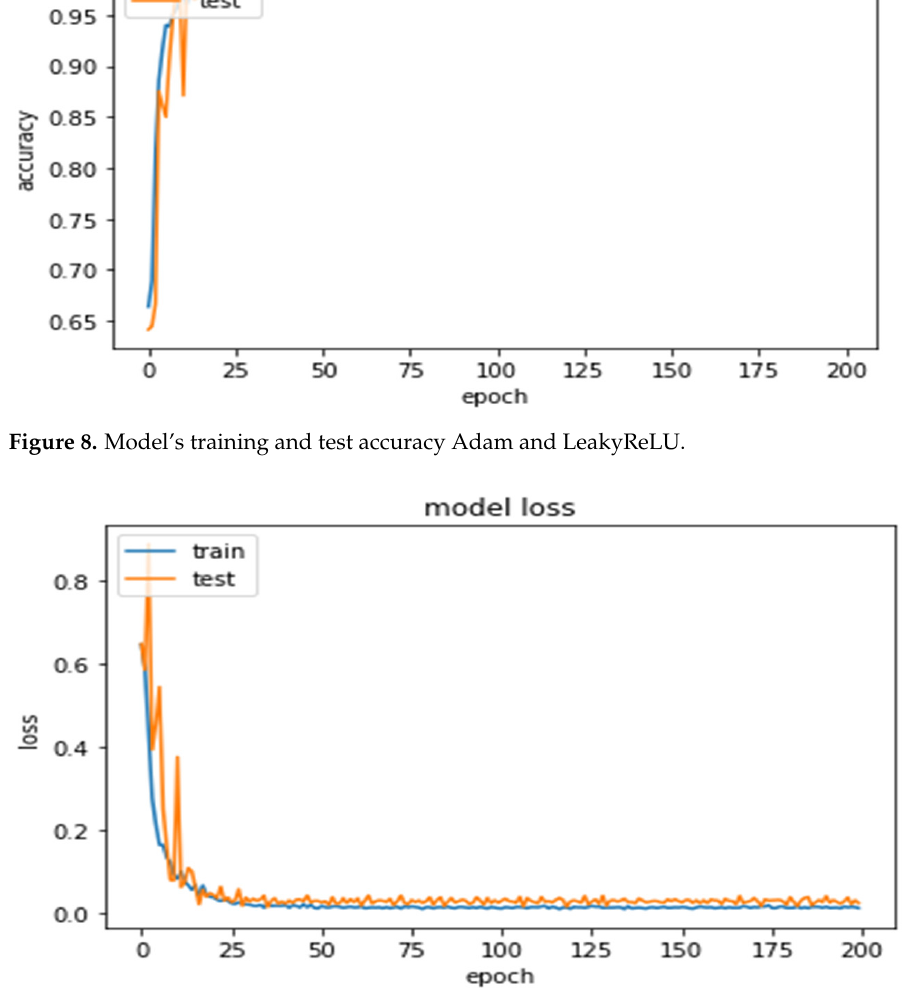
Figure 9. Model’s training and test loss over epochs with Adam and LeakyReLU.